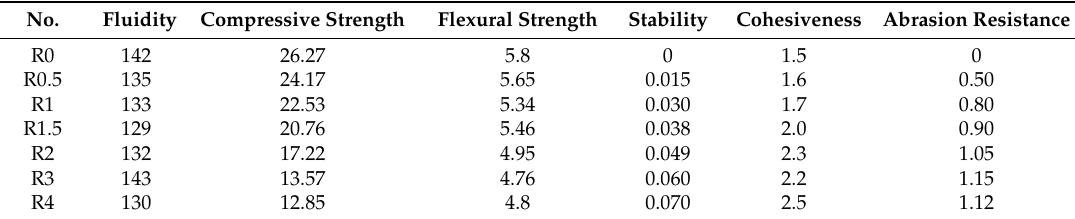
Table 8. Parameters for performance evaluation of SLM.